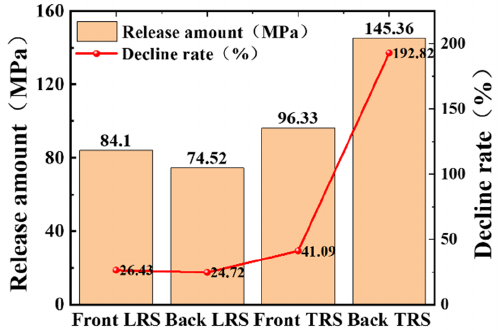
Figure 6. Change in average peak residual stress after cutting.